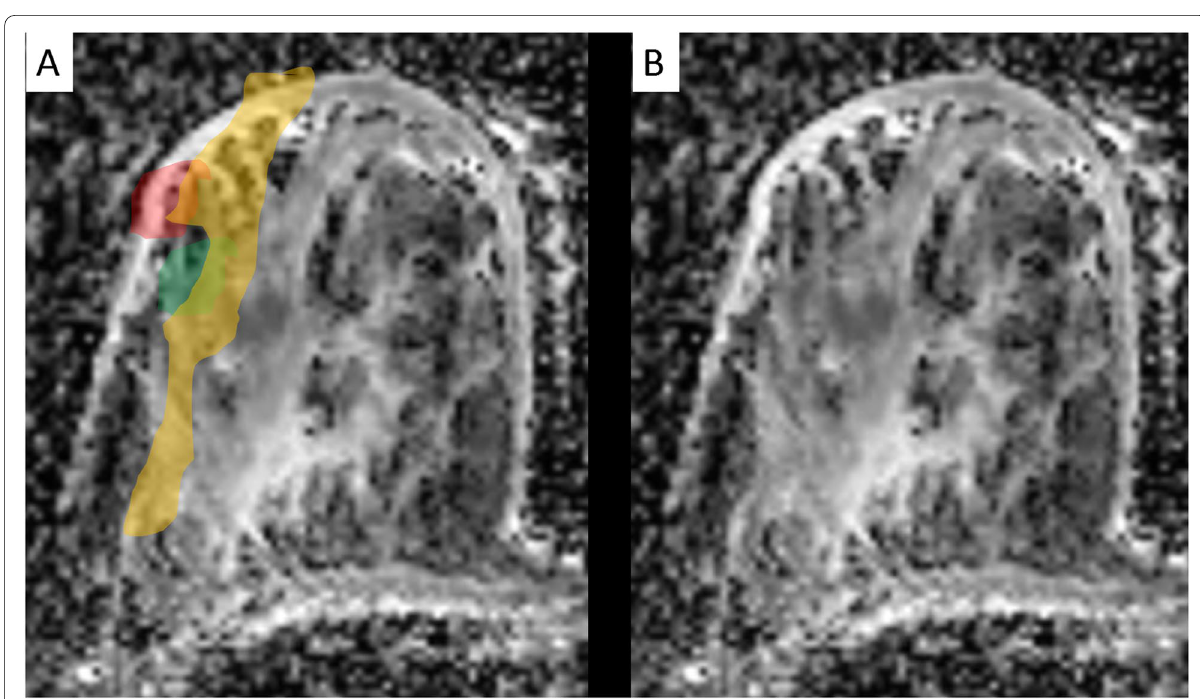
Fig. 7 Apparent diffusion coefficient (ADC) mapping (detailed analysis of the DWI already shown in Fig. 1). ADC values are extracted using quantitative region‑of‑interest‑based measurements by standardised methods. ADC is given with ( A ) and without ( B ) colour overlap. ADC was applied to distinguish ductal carcinoma in situ (DCIS, orange) from invasive carcinoma (red). Note the presence of a benign lesion (a fibroadenoma), also correctly characterised by the ADC map (green), adjacent to the